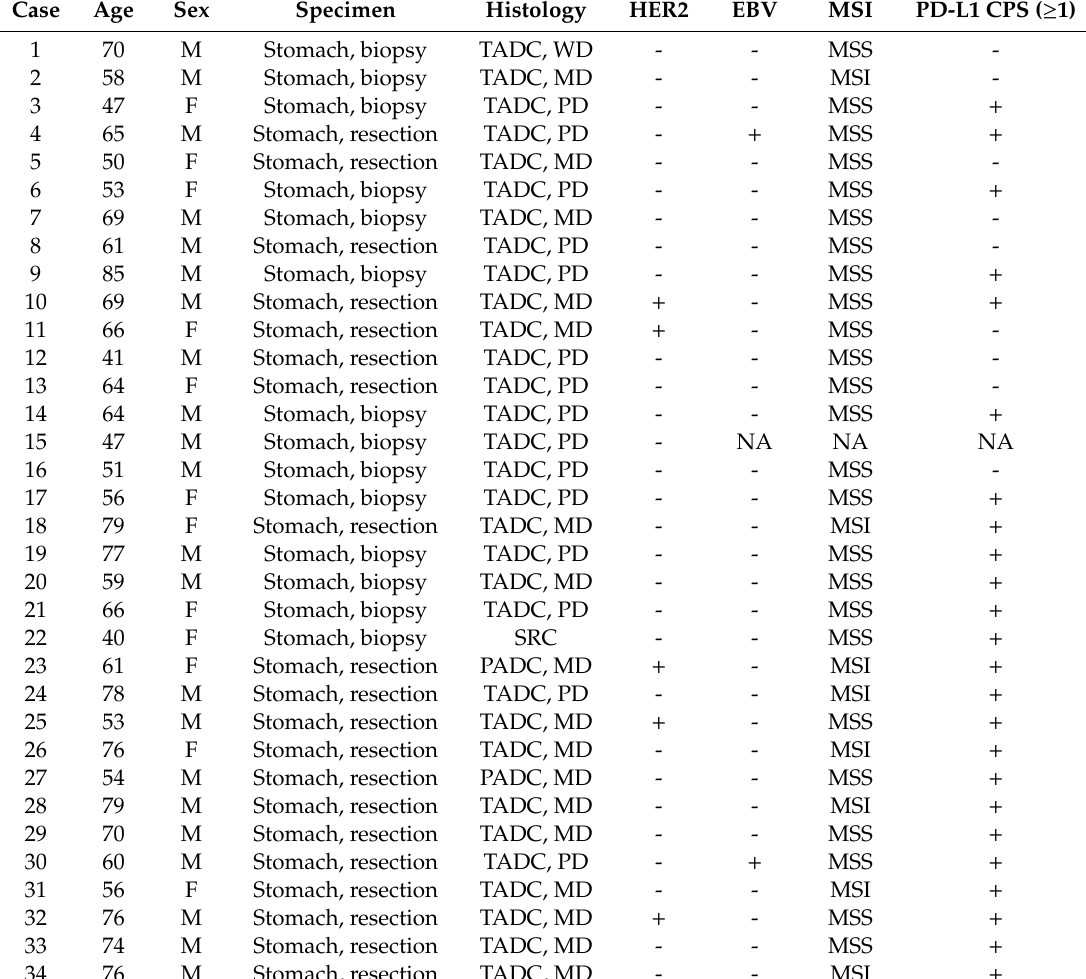
Table 1. Clinicopathologiccharacteristicsofphosphataseandtensinhomolog( PTEN